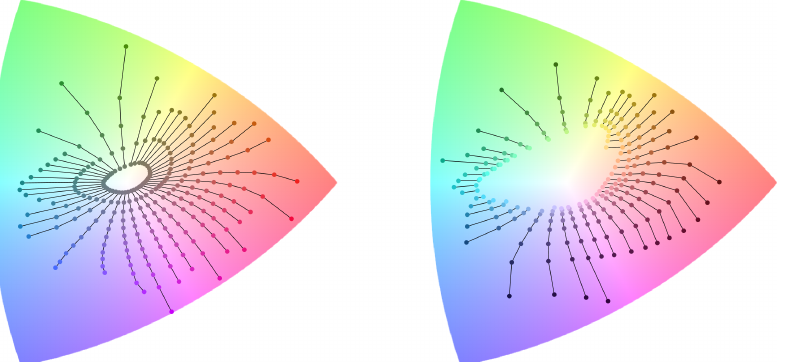
Figure 7. Visualization of Munsell patches converted from sRGB to ARC diagram, grouped by the Munsell hue. On the left: patches having Munsell value = 5. On the right: patches having Munsell chroma = 8. The underlying colors of the ARC diagram have been reduced in contrast for better visualization of the Munsell